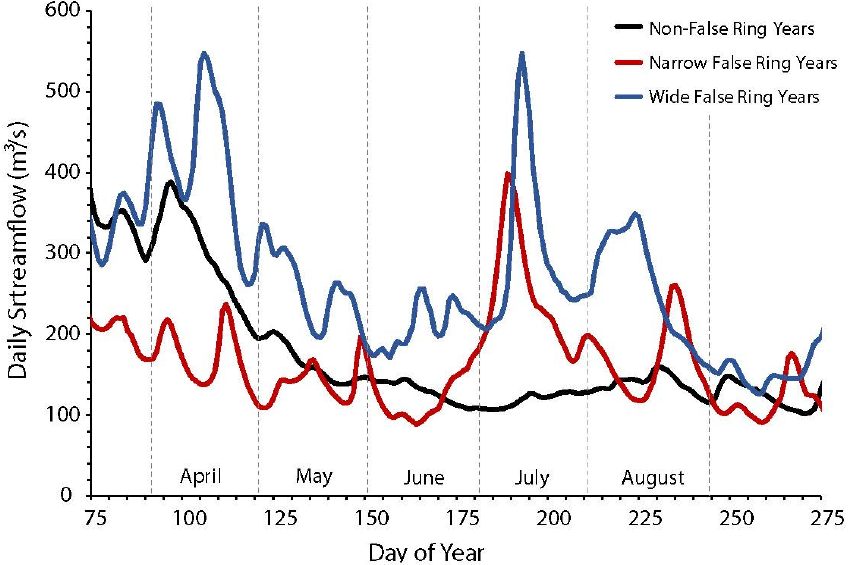
Figure 5. Average daily streamflow (day of year) for non-HFR years (black line), narrow HFR years (red line) and wide HFR years (blue line).